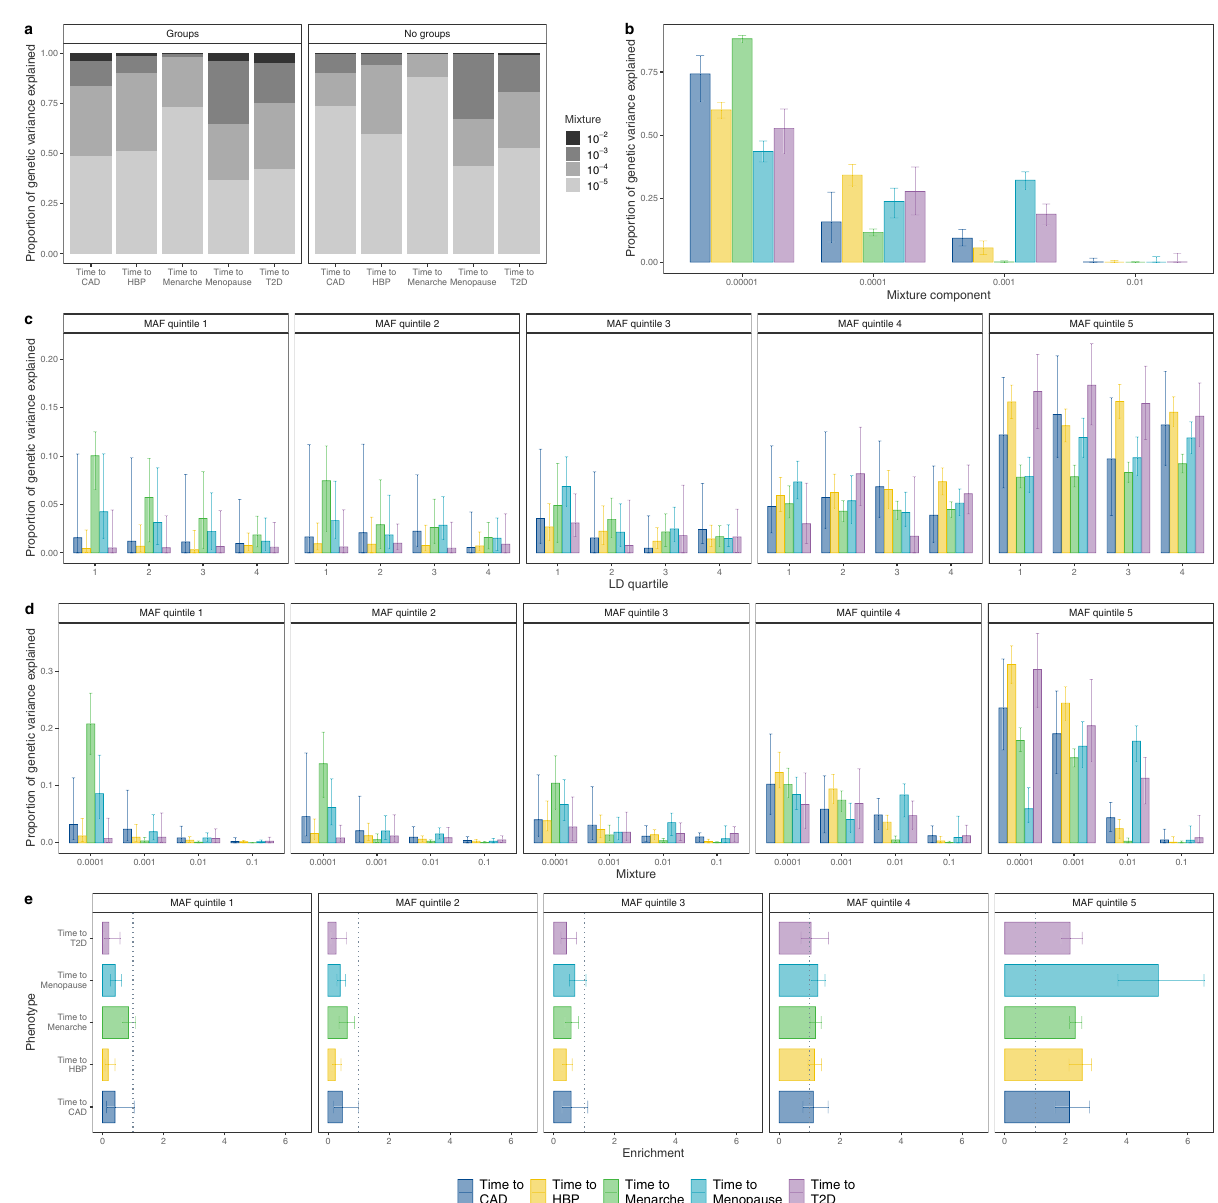
Fig. 2 Genetic architecture for time-to-diagnosis of CAD, HBP, T2D and age-at-menarche and age-at-menopause, estimated using 2,975,268 markers and unrelated European ancestry individuals from the UK biobank. BayesW models were executed with and without partitioning the markers into groups. Groups were created by splitting them fi rst into MAF quintiles and each MAF quintile was further split into quartiles based on LD giving us a total of 20 groups. The used sample sizes were N = 360,715; 371,878; 372,280; 200,493 and 151,472 for time-to-diagnosis of CAD, HBP, T2D and age-at-menarche and age-at-menopause, respectively. The models without groups were run with fi ve chains and the models with groups were run with three chains, each chain contained 10,000 iterations out of which 5000 fi rst iterations were discarded as burn-in and a thinning step of fi ve was applied to give 1000 samples from each chain. a Mean proportions of genetic variances explained by each of the mixtures with the groups model and without groups model, groups model and no group model are yielding rather similar results; ( b ) distribution of proportion of genetic variance between mixtures for the model without groups, time-to-menarche stands out with almost all of genetic the variance attributed to the small mixtures; ( c ) distribution of proportion of genetic variance between LD quartiles within each MAF quintile, LD bins do not have a large impact on genetic variance partitioning as the credibility intervals are large and medians across LD quartiles are rather stable; ( d ) distribution of proportion of genetic variance between mixtures within each MAF quintile, mixture allocations tend to be similar compared to no groups model; ( e ) enrichment (ratio of proportion of genetic variance and proportion of markers attributed to each MAF quintile group) value for each phenotype, enrichment of higher than 1 represents that the markers are explaining more of the genetic variance compared to their count proportion and vice versa. b – e Height of the bars represents median and error bars represent 95% credibility intervals, ( c – e ) are group models. For all of the traits, most of the genetic variance is coming from common SNPs (MAF quintile